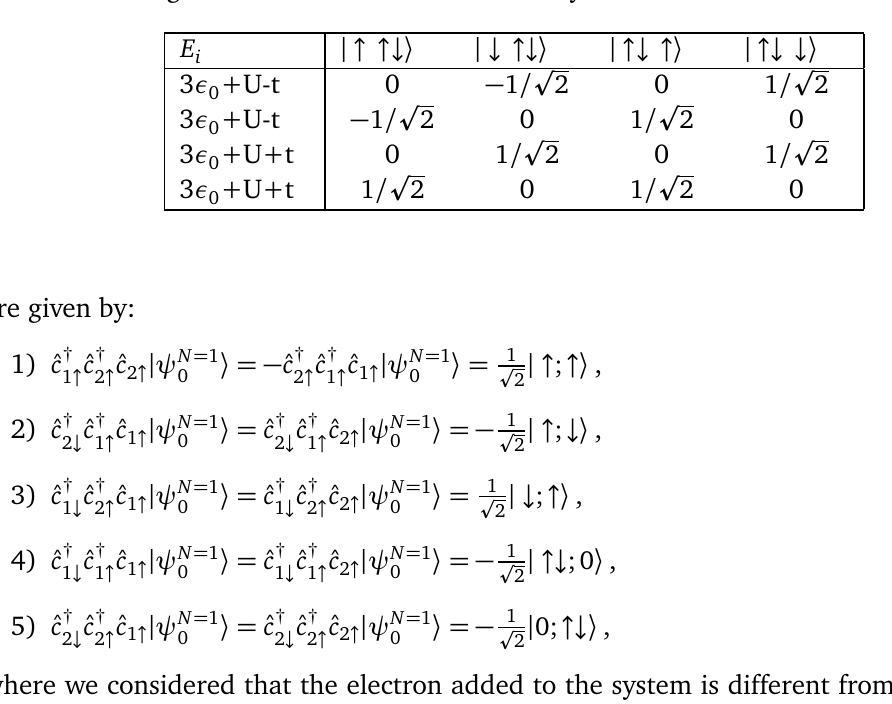
Table 3: Eigenvalues and coefficients of the symmetric Hubbard dimer for N =